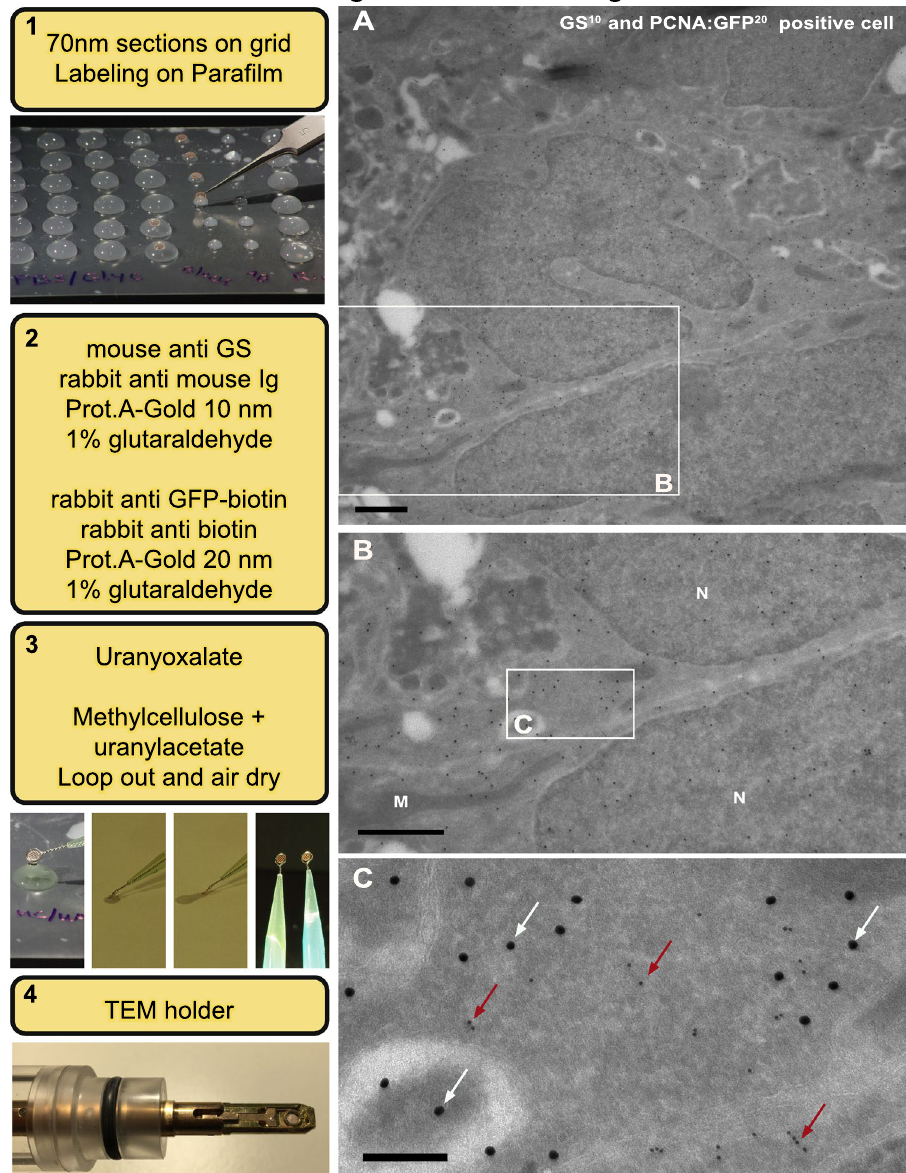
Figure 6. TEM immuno-gold double-labelling workflow and example of positive labelling on Tokuyasu chemical-fixed cryosections. Left: Major steps (1–4) required for TEM immuno-gold double-labelling workflow and associated images. ( A , B,C ) Cytosolic PCNA:GFP + /GS + immuno-gold double-labelling at low ( A ) and high ( B,C ) magnifications demonstrating co-localization of the 10 nm (GS; red arrowheads) and 20 nm (PCNA:GFP; white arrowheads) particles. N, nucleus. Scale bar ( A ) 2 µm; ( B,C ) 200